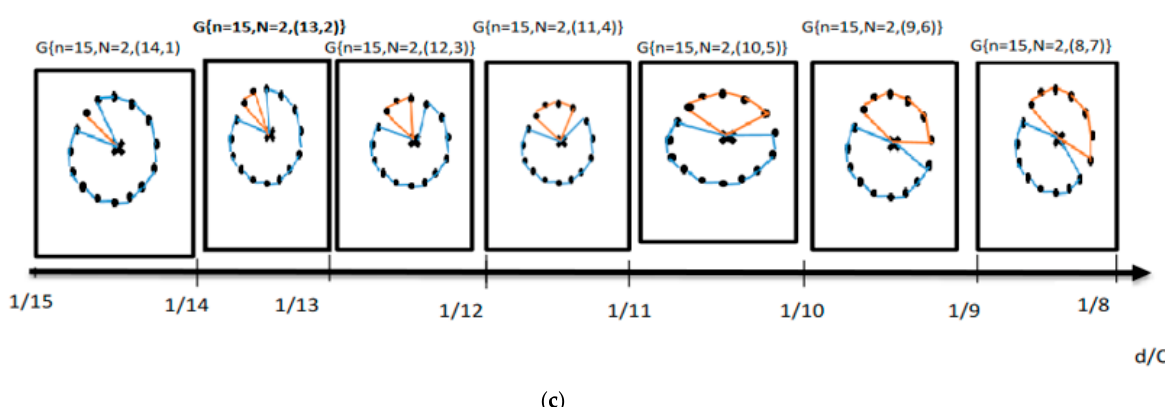
Figure 3. Set of possible graphs corresponding to the various domains of d/C for N = 2, ( a ) n = 12, ( b ) n = 13, and ( c ) n = 15.